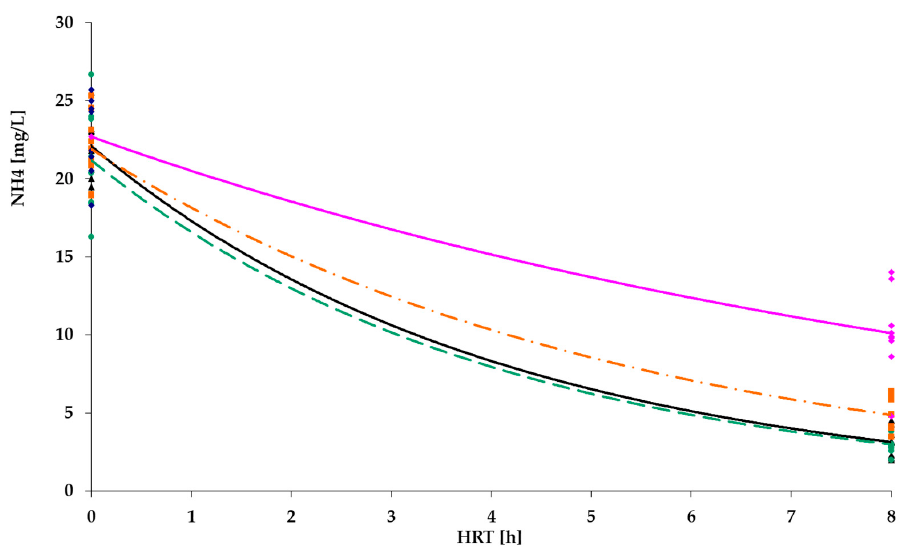
Figure 9. Ammonium removal dynamics if: floating carrier is 10% of reactor volume (black); 20% of tank volume (green); 30% of tank volume (orange); no carrier in the reactor (magenta). Table 2. Average values of treatment for PS-carrier.